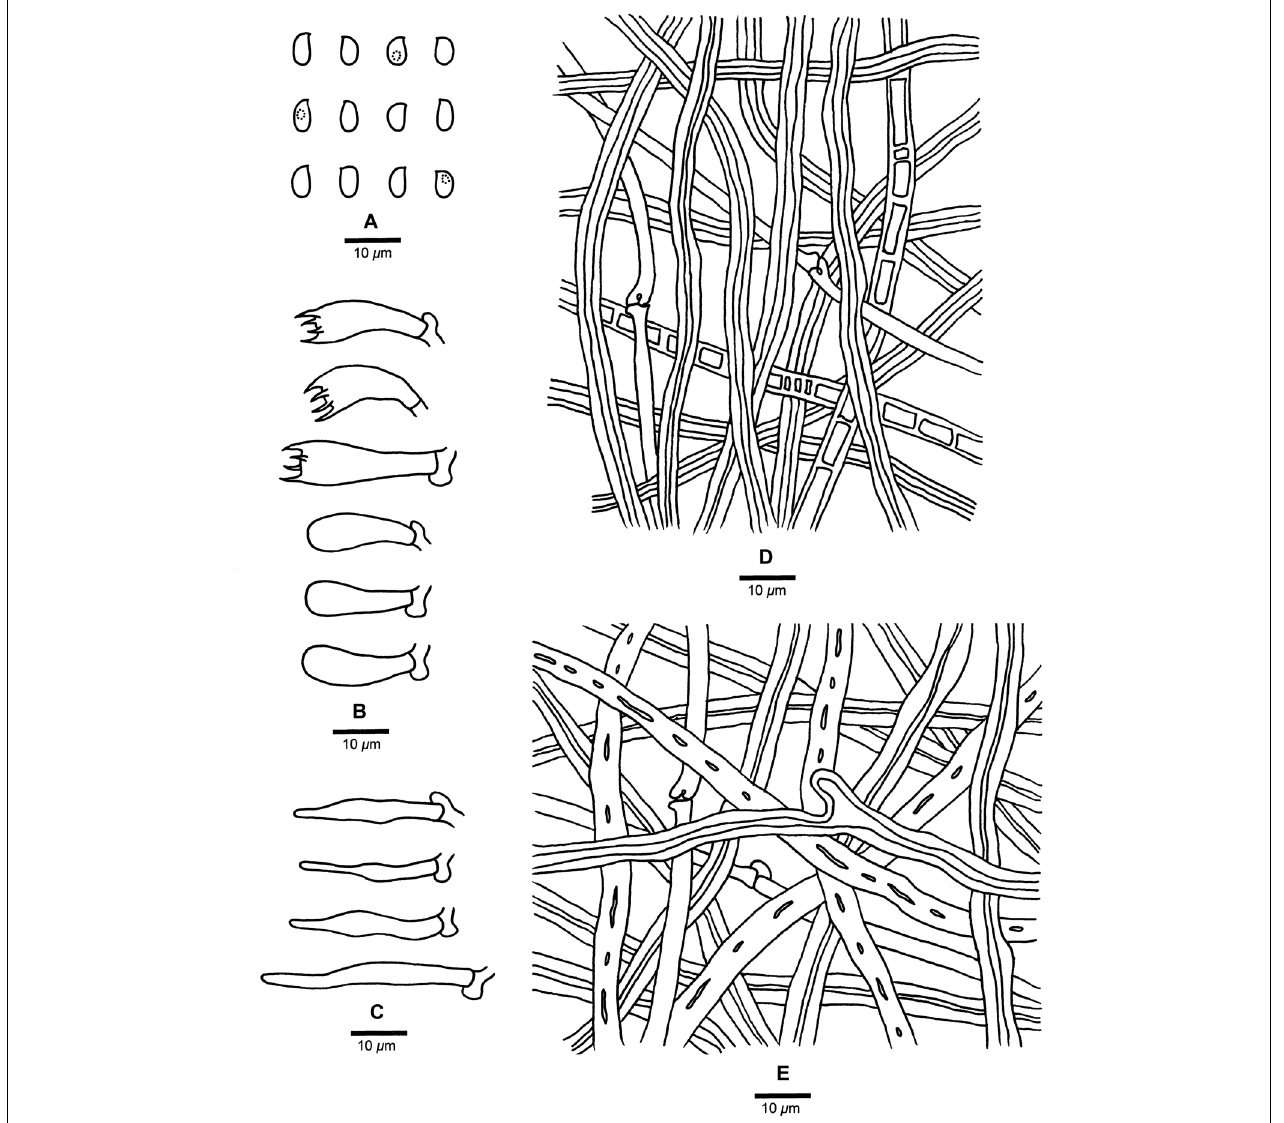
FIGURE 8 | Microscopic structures of Fomitopsis subpinicola (drawn from the holotype). (A) Basidiospores; (B) Basidia and basidioles; (C) Cystidioles; (D) Hyphae from trama; (E) Hyphae from context. Bars: A–E = 10 µ